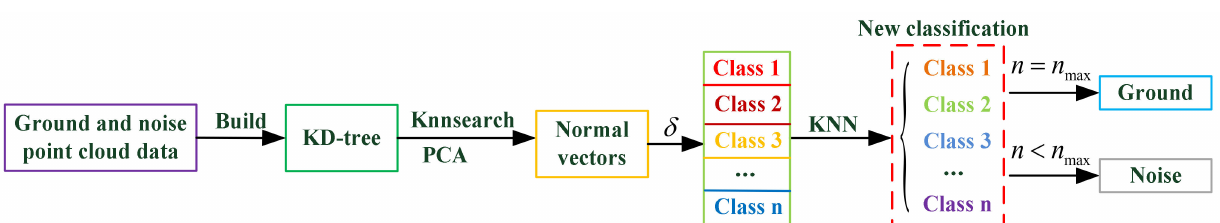
Figure 4. Filtering based on the normals K nearest neighbor (NKNN) is presented. The data obtained consists of ground and noise in the previous step. A KD-tree is built for the data. KD-tree is used to search for the KNN. Then, the PCA algorithm is used to quickly solve the normal vector. The data are classified by setting the threshold δ of the angle between the normal vectors. Then, the KNN algorithm is used for further optimization. Of all the categories, the category with the most points is the ground point cloud, and the others are